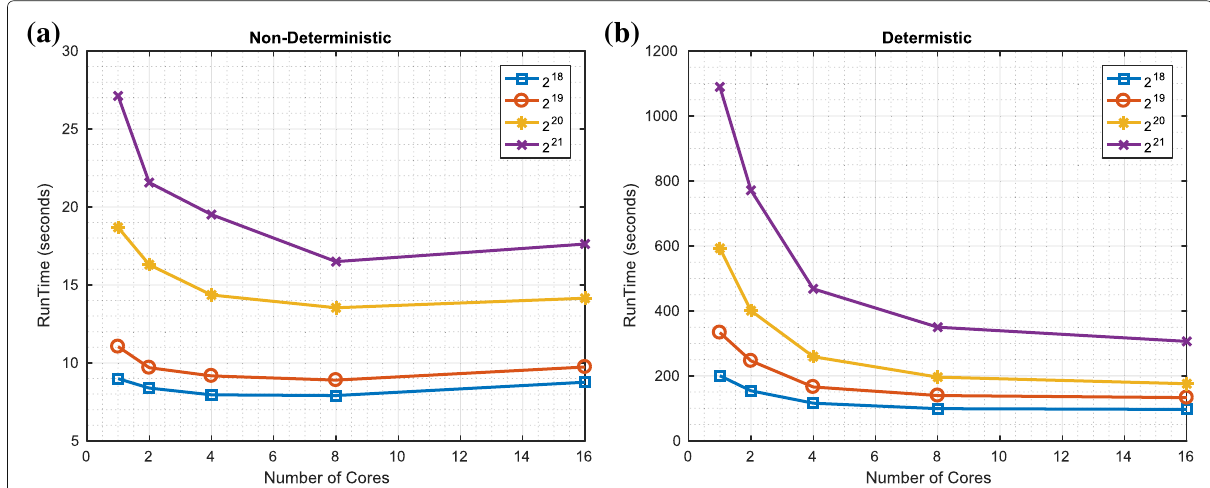
Fig. 5 Worst-case performance of redistribution: platform 1. a Naïve implementation. b Proposed